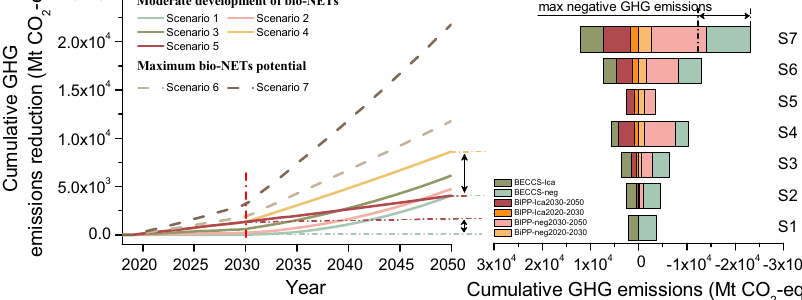
Fig. 6 Cumulative GHG emissions reduction during 2020 – 2050 compared with BAU and cumulative GHG emissions. The net life-cycle GHG emissions are studied taking account of carbon fi xation by biochar/carbon storage by BECCS, life-cycle GHG emissions for a BIPP/BECCS system and biochar soil effect of biochar sequestration (see “ Method ” , Eq. (2)). The GHG emissions reduction is attributed to biochar production in the studied pyrolysis (BIPP) systems or/and BECCS (including fossil fuel offset and net life-cycle GHG emissions). Results are shown for seven scenarios, in which solid lines indicate the scenarios under “ Moderate development of bio-NETs ” , dashed lines under “ Maximum bio-NETs potentials ”